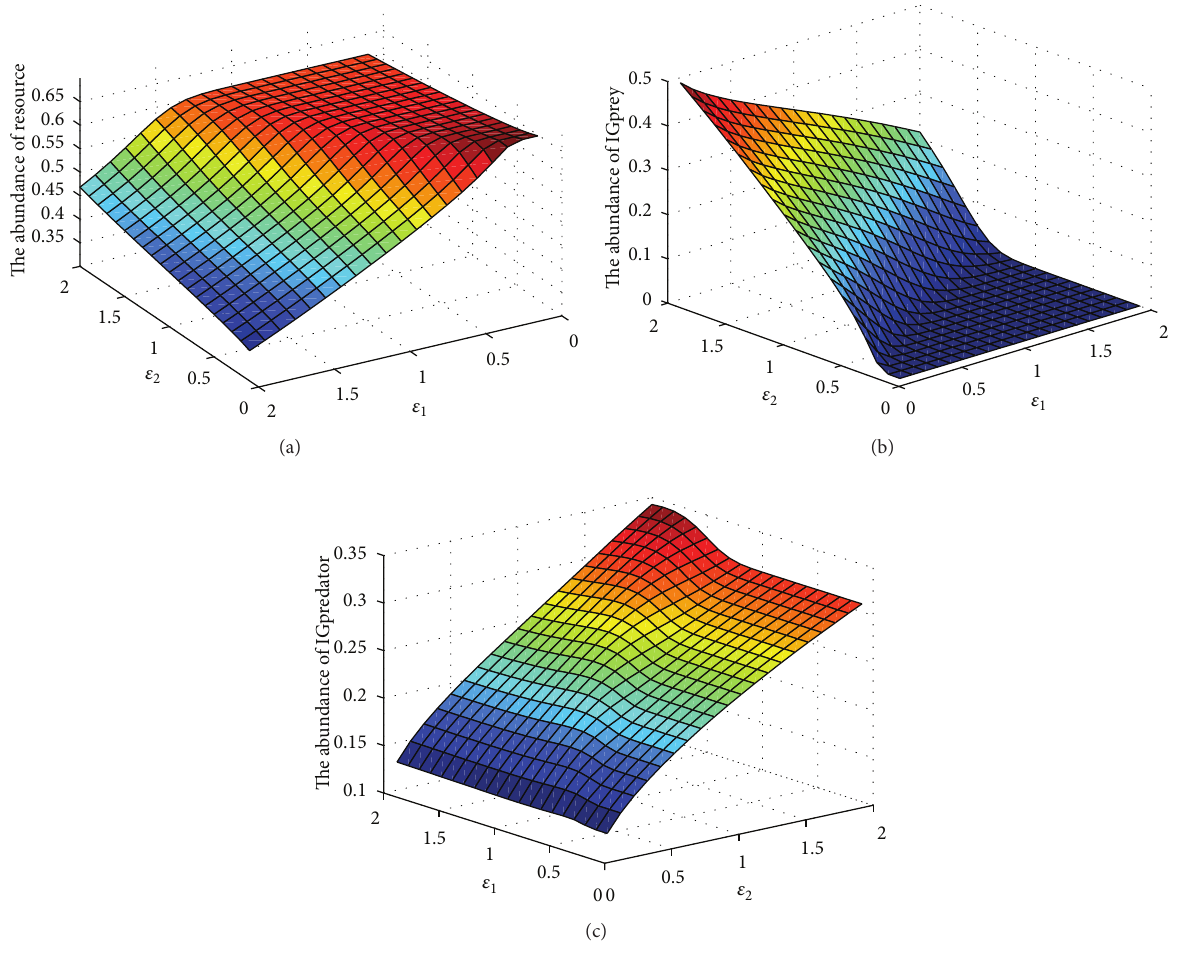
Figure 7: Long-term (equilibrium) abundances of the resource, the IGprey and the IGpredator as a function of the IGprey’s dispersal rate ( 𝜀 1 ) and the IGpredator’s dispersal rate ( 𝜀 2 ). Parameter values used are 𝜅 1 = 0.7, 𝜅 2 = 0.4, 𝜅 3 = 0.4, 𝛼 = 2 , ℎ = 0.5, 𝑒 1 = 0.1 , and 𝑒 2 = 0.21